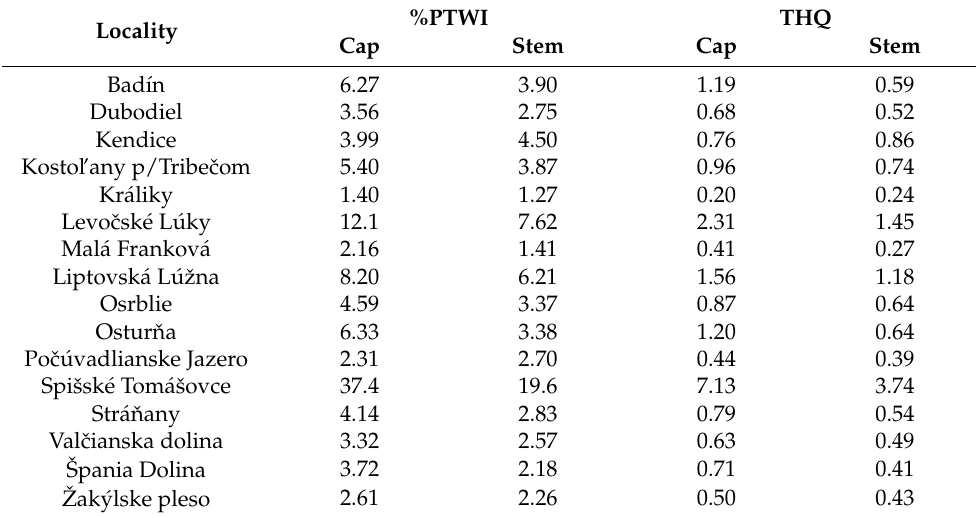
Table 5. THQ values and %PTWI of the studied mushrooms based on Hg content according to the geographical